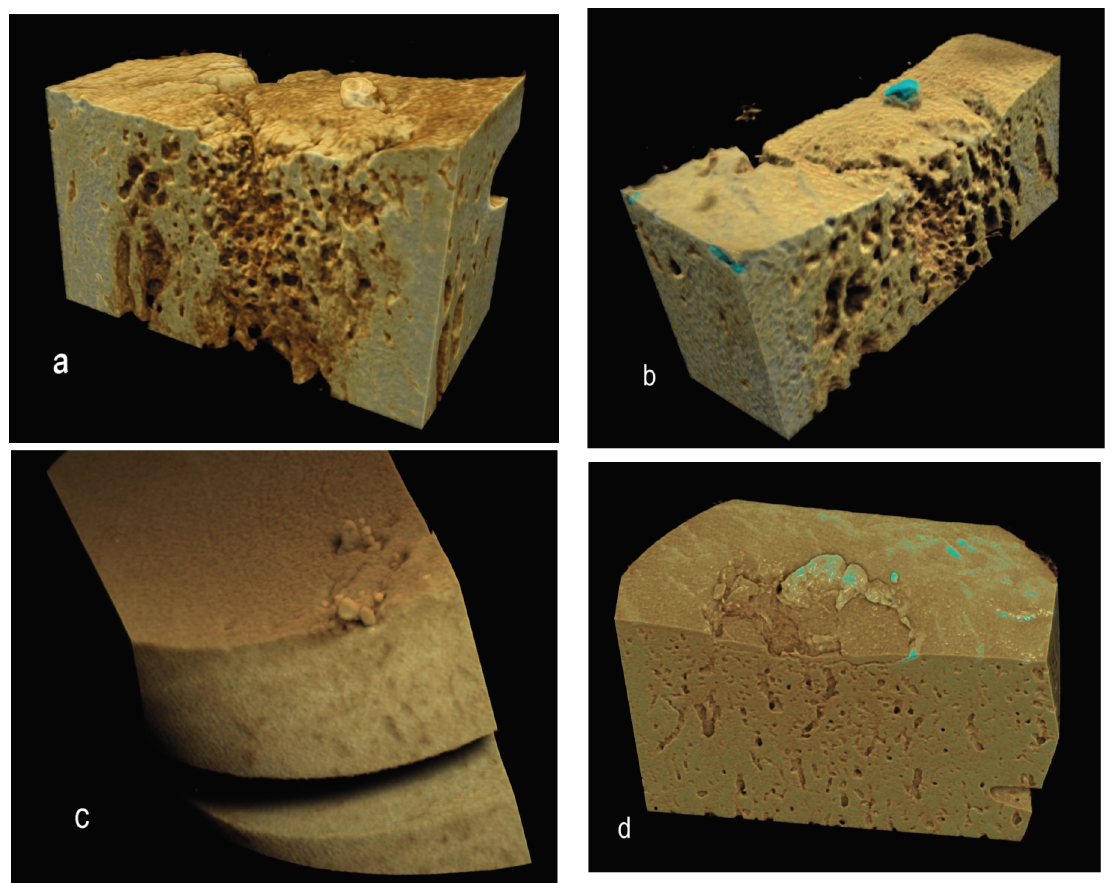
Figure 5. Drishti renderings showing high-density mineralized protrusions from the ACC MF: ( a , b ) Four-year-old, advanced OA; ( c ) Advanced OA, seven-year-old; and ( d ) Early OA,